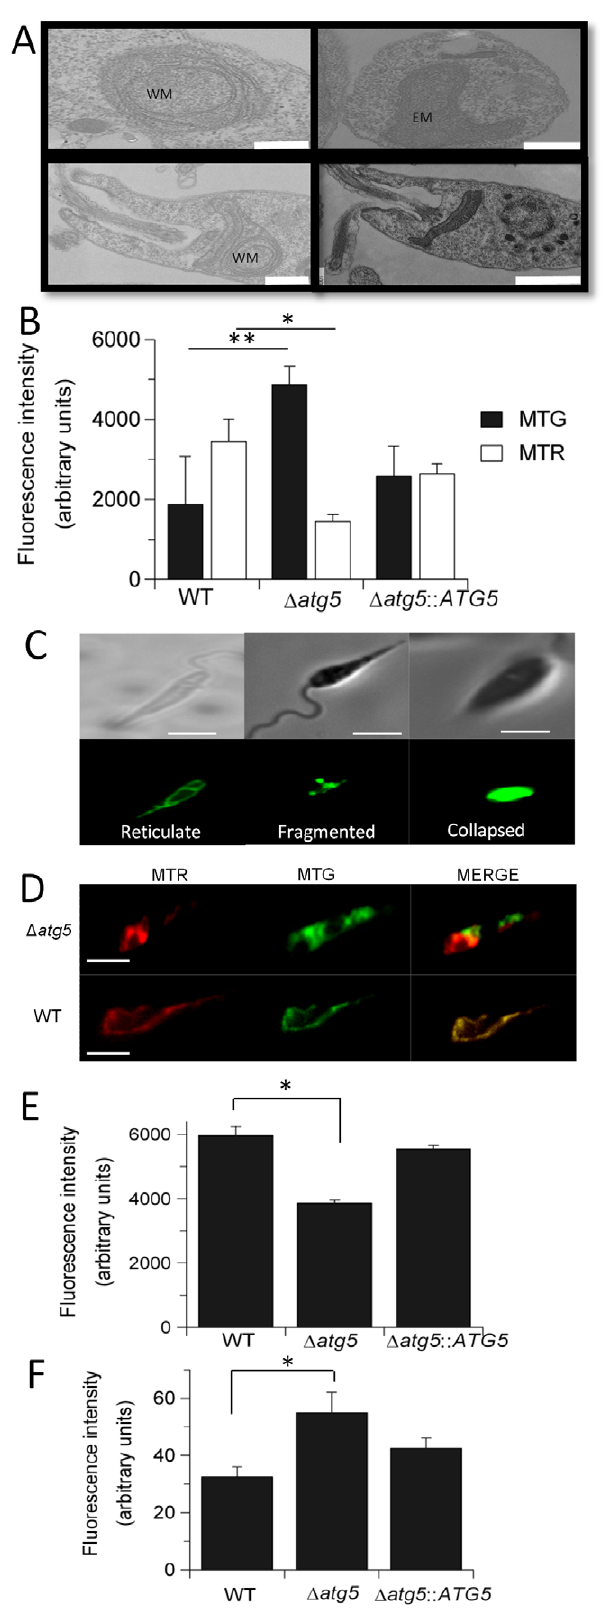
Figure 5. L.major D atg5 promastigotes have a dysfunctional mitochondrion. (A) Enlarged (EM) and swollen (WM) mitochondria seen by transmission electron microscopy (TEM) in D atg5